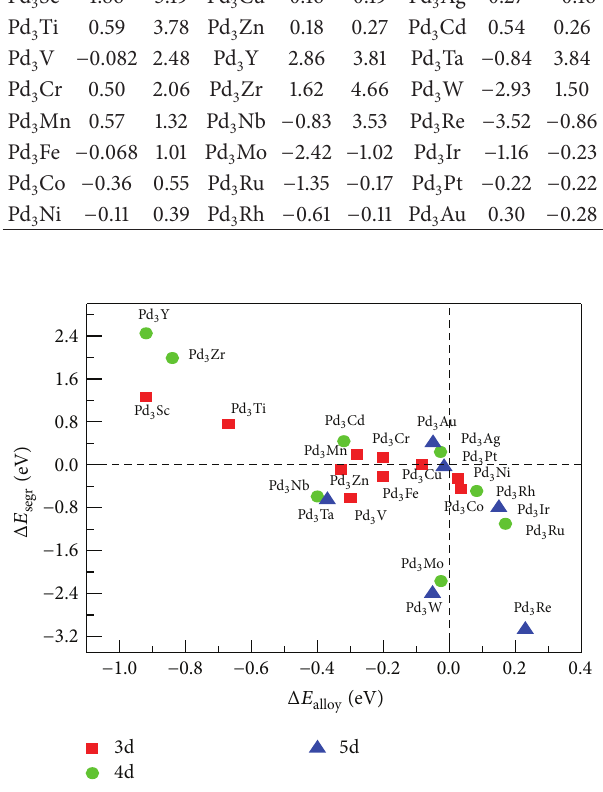
Figure 5: Relation between the DFT-calculated segregation energy ) of Pd and formation energies in Pd 3 M alloys: stability ( Δ𝐸 segr